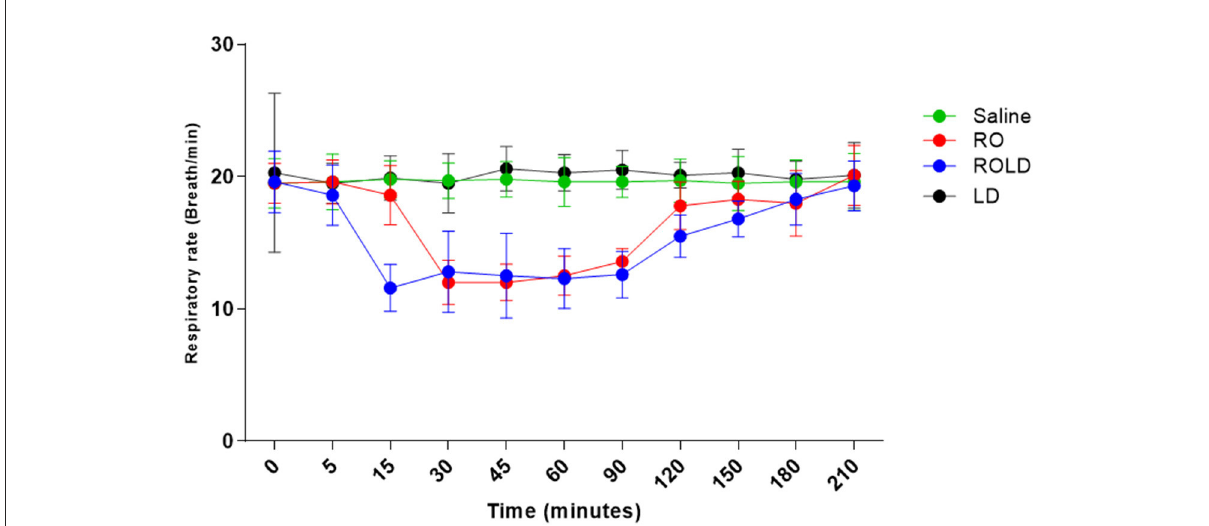
FIGURE8 Respiratory rate (respiratory cycle / Min mean and standard deviation) pre-epidural and post-epidural administration of saline ( n = 6), romifidine (RO) (50 µ g kg − 1) ( n = 6), romifidine-lidocaine (ROLD) (50 µ g and 0.30mg kg − 1) ( n = 6) and lidocaine (LD) (0.3 0mg kg − 1) ( n = 6) in donkeys. Wilks Lambda test for time x treatment, P < 0.01, indicates significant changes in respiratory rate under the effect of treatment and time. However, sphericity assumed test indicates the effect of time (within-treatment). Wilks Lambda test for time x treatment interaction P < 0.01. Sphericity assumed test for the effect of time (within-treatment), P <